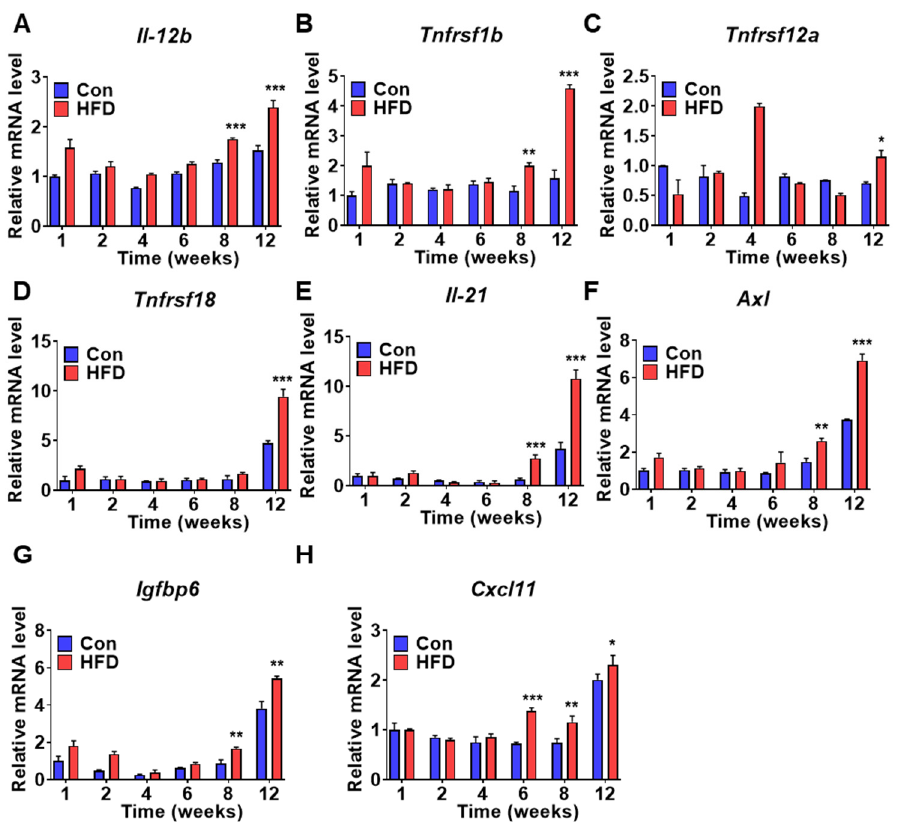
Figure 7. Diabetes marker gene expression is induced in T2DM stage after HFD: ( A – H ) Expression of diabetes marker genes was promoted in HFD-fed WT mice. mRNA levels of Il-12b, Tnfrsf1b, Tnfrsf12a, Tnfrsf18, Il-21, Axl, Igfbp6, and Cxcl11 from liver tissue were measured by qPCR analysis